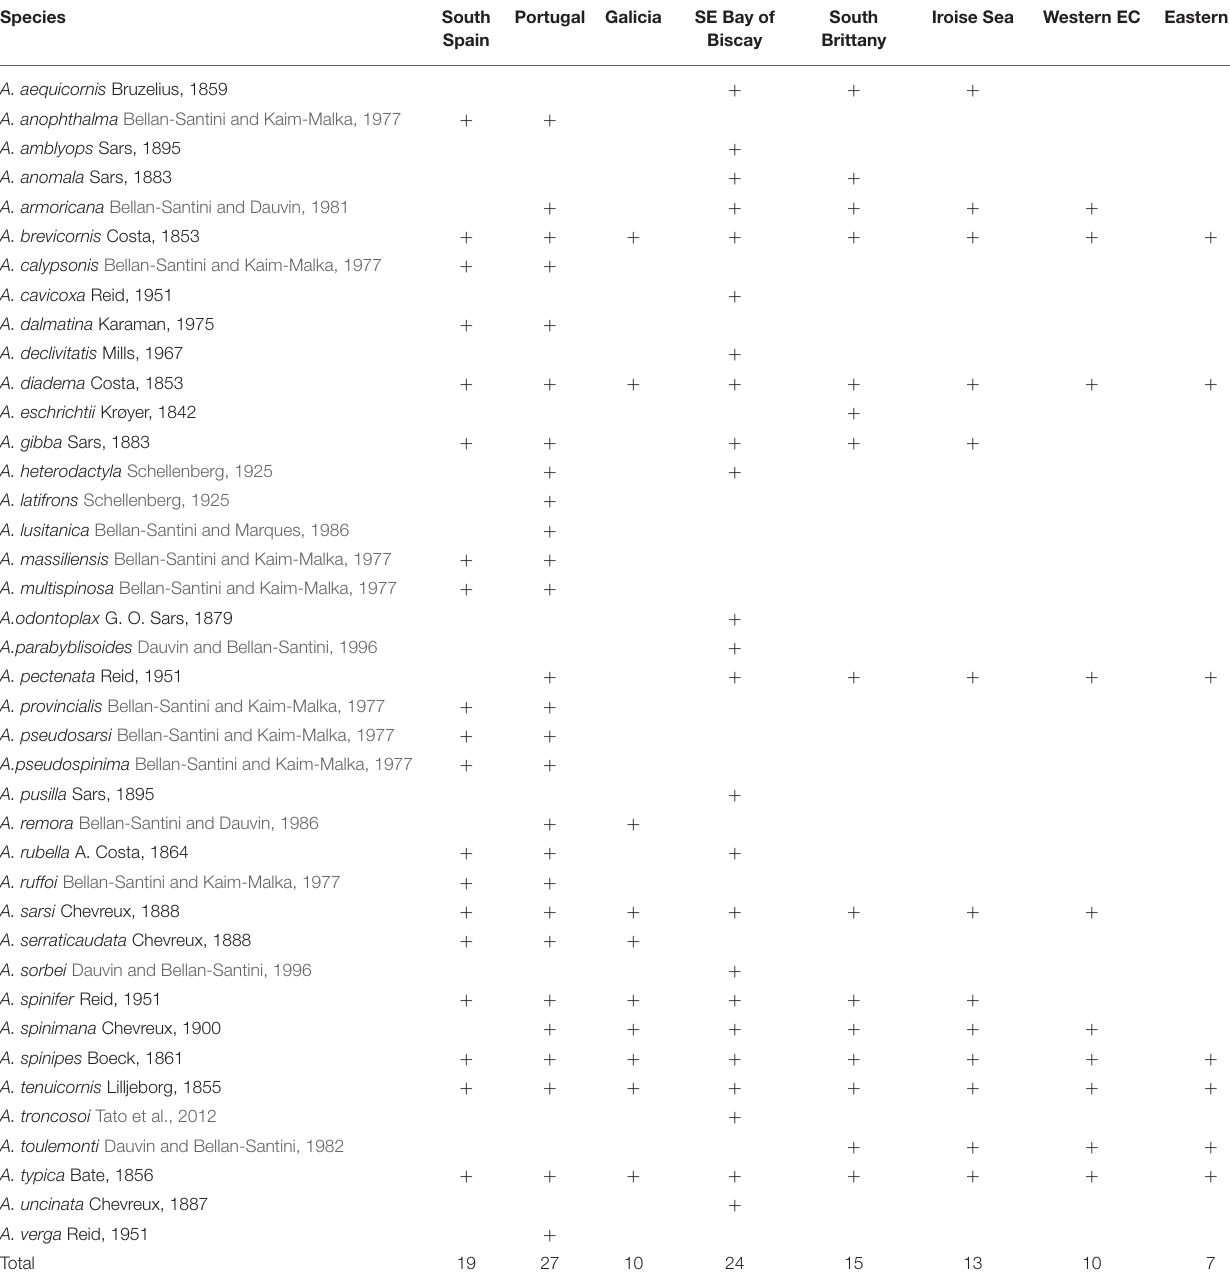
TABLE 1 | Latitudinal distribution of Ampelisca from the Strait of Gibraltar (south Atlantic coast of Spain) to the Strait of Dover.